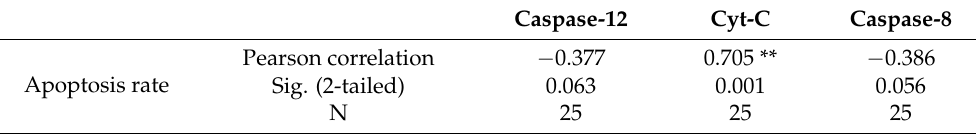
Table 1. Correlation analysis between the apoptosis rate and apoptotic proteins at the IE stage.